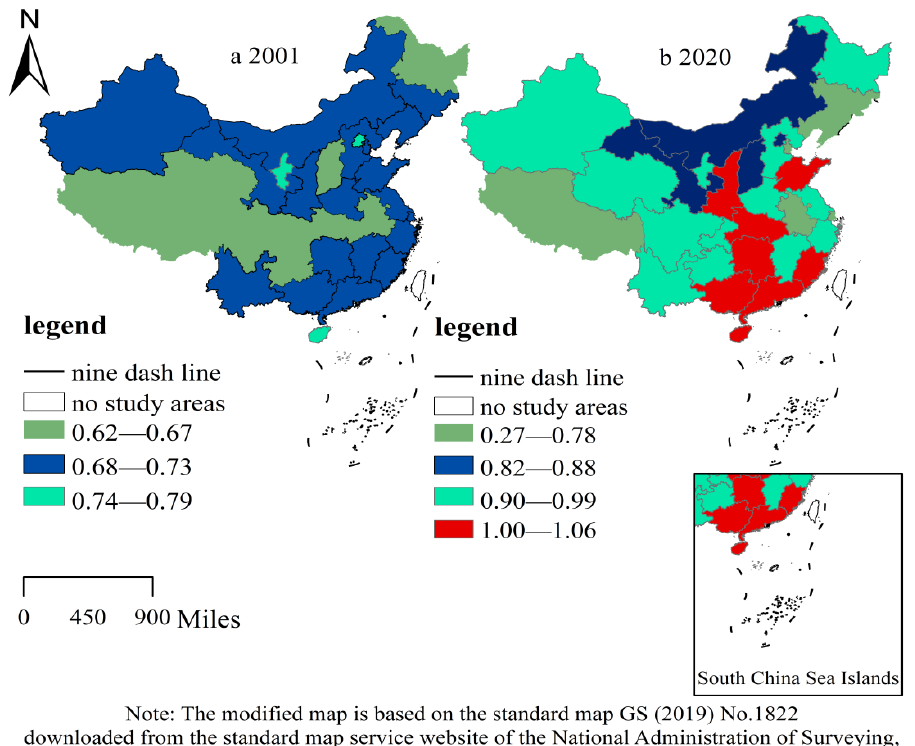
Figure 3. Spatial-temporal evolution characteristics of agricultural green development.